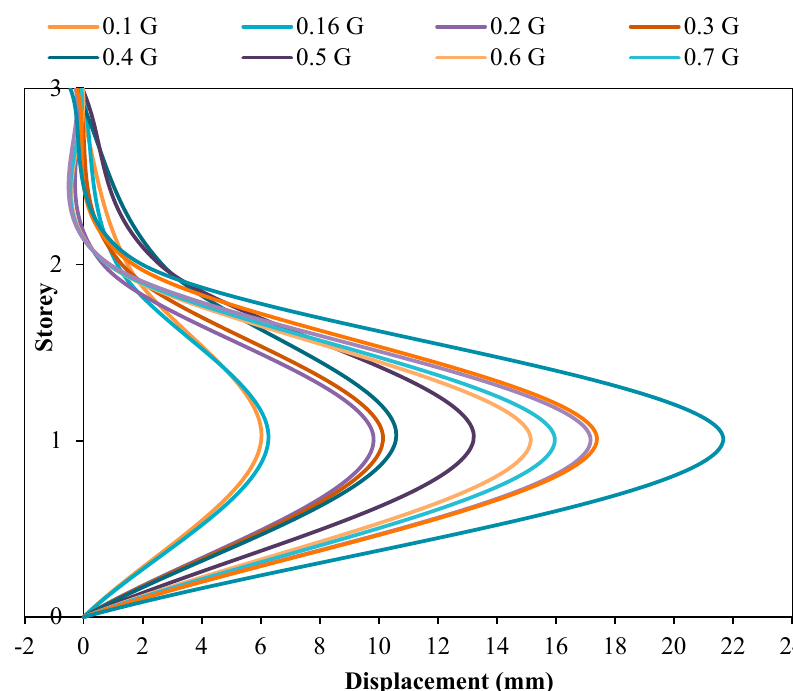
Figure 11. Inter-storey drift of structure without dampers.